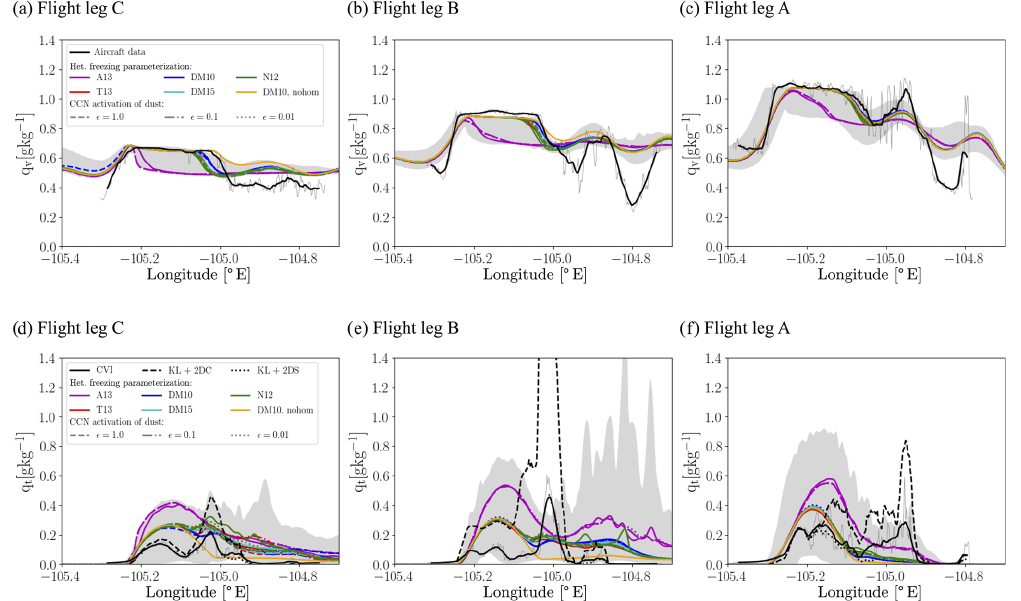
Figure 4. Comparison of (a–c ) specific humidity and (d–f) total condensation mass mixing ratio for the three different flight legs. The flight legs are shown in the sequence of decreasing flight altitude from left to right. The thick black line shows the smoothed aircraft data (thin black line shows 1Hz data). For the total water content (d–f) data from the CVI (thick solid black line) as well as the sum of King liquid water probe data and 2DS (2DC) data (black dashed (dotted) line) are shown. Model data are interpolated to the same tangents of the mean streamlines as used in Fig. 3. With the exception of the CVI data, the observed total water content includes only ice crystals larger than 50µm. From the model results, the ice water content for ice crystals larger than 50µm is computed by integrating over the respective part of the assumed size distribution in the model using the prognostic variables of ice number concentration, ice mass mixing ratio, and the fixed shape parameter. The modelled variability in the variable along all these hypothetical flight paths is shown by the grey shading, while the thick coloured lines show the median values for simulations. The different coloured lines represent the different ice nucleation schemes, and different line styles indicate different assumptions about the amount of soluble material in the dust particles (solid: all dust acting as